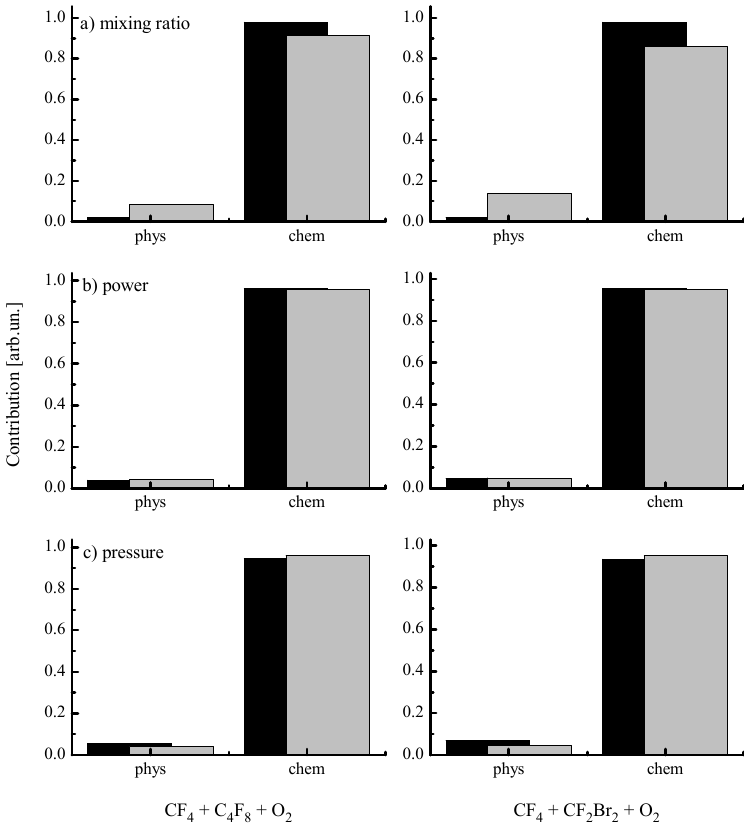
Figure 5. Relative contributions of physical and chemical etching pathways to the SiO x N y etching rate. Black and gray bars in ( a – c ) correspond to lowest and highest values of variable parameters from Figures 1–3, respectively.